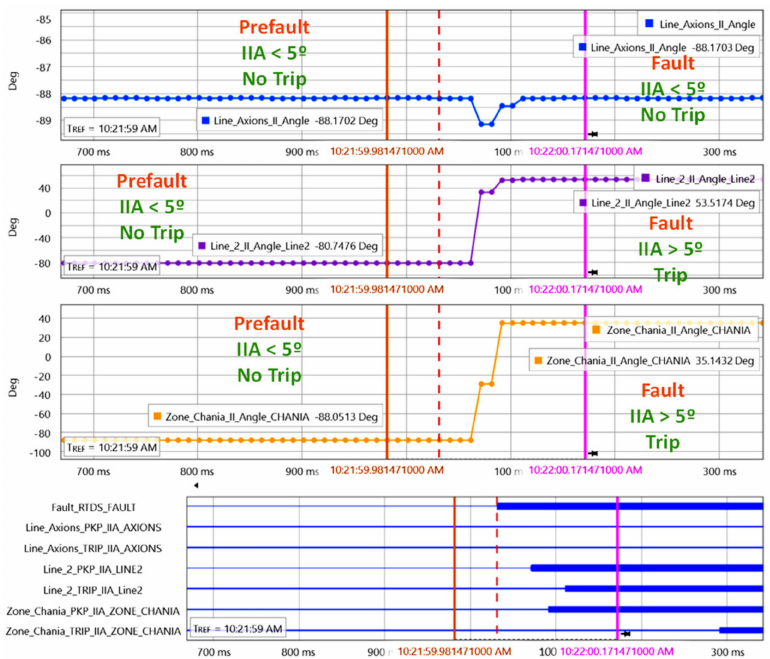
Figure 30. Line/Zone IIA behaviour; 1PH fault in 50% of Line 2; Rfault = 1 Ω ; zero reactors connected.